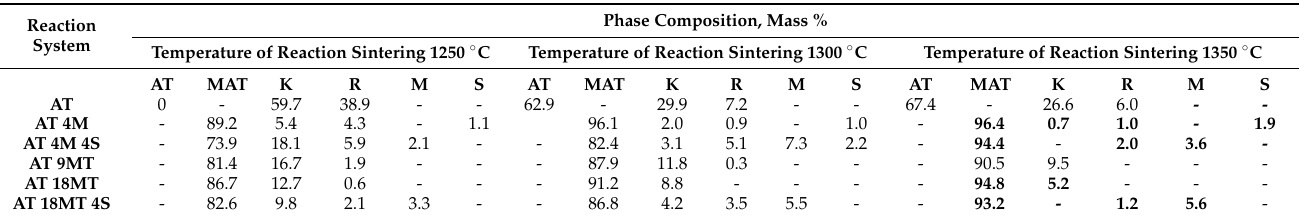
Table 2. Phase composition of synthesis products as a function of synthesis temperature and starting substrate